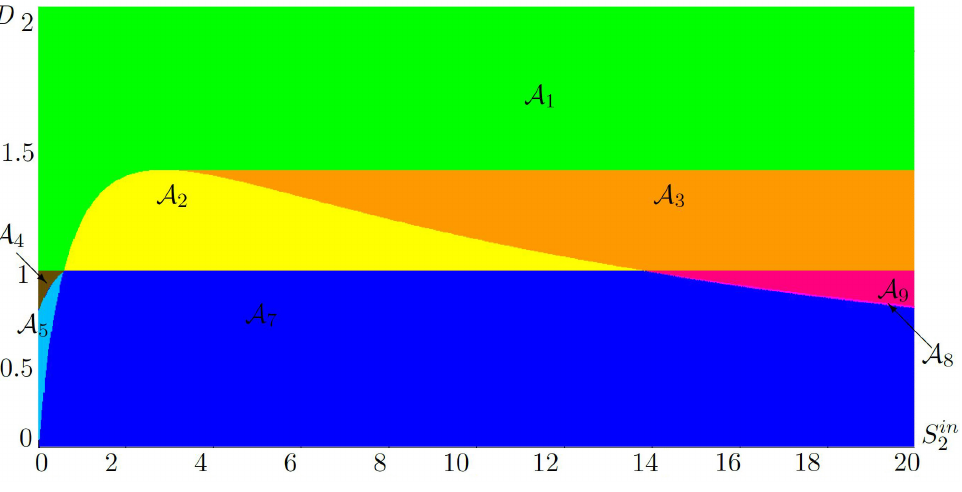
Figure 6. The operating diagram for S in